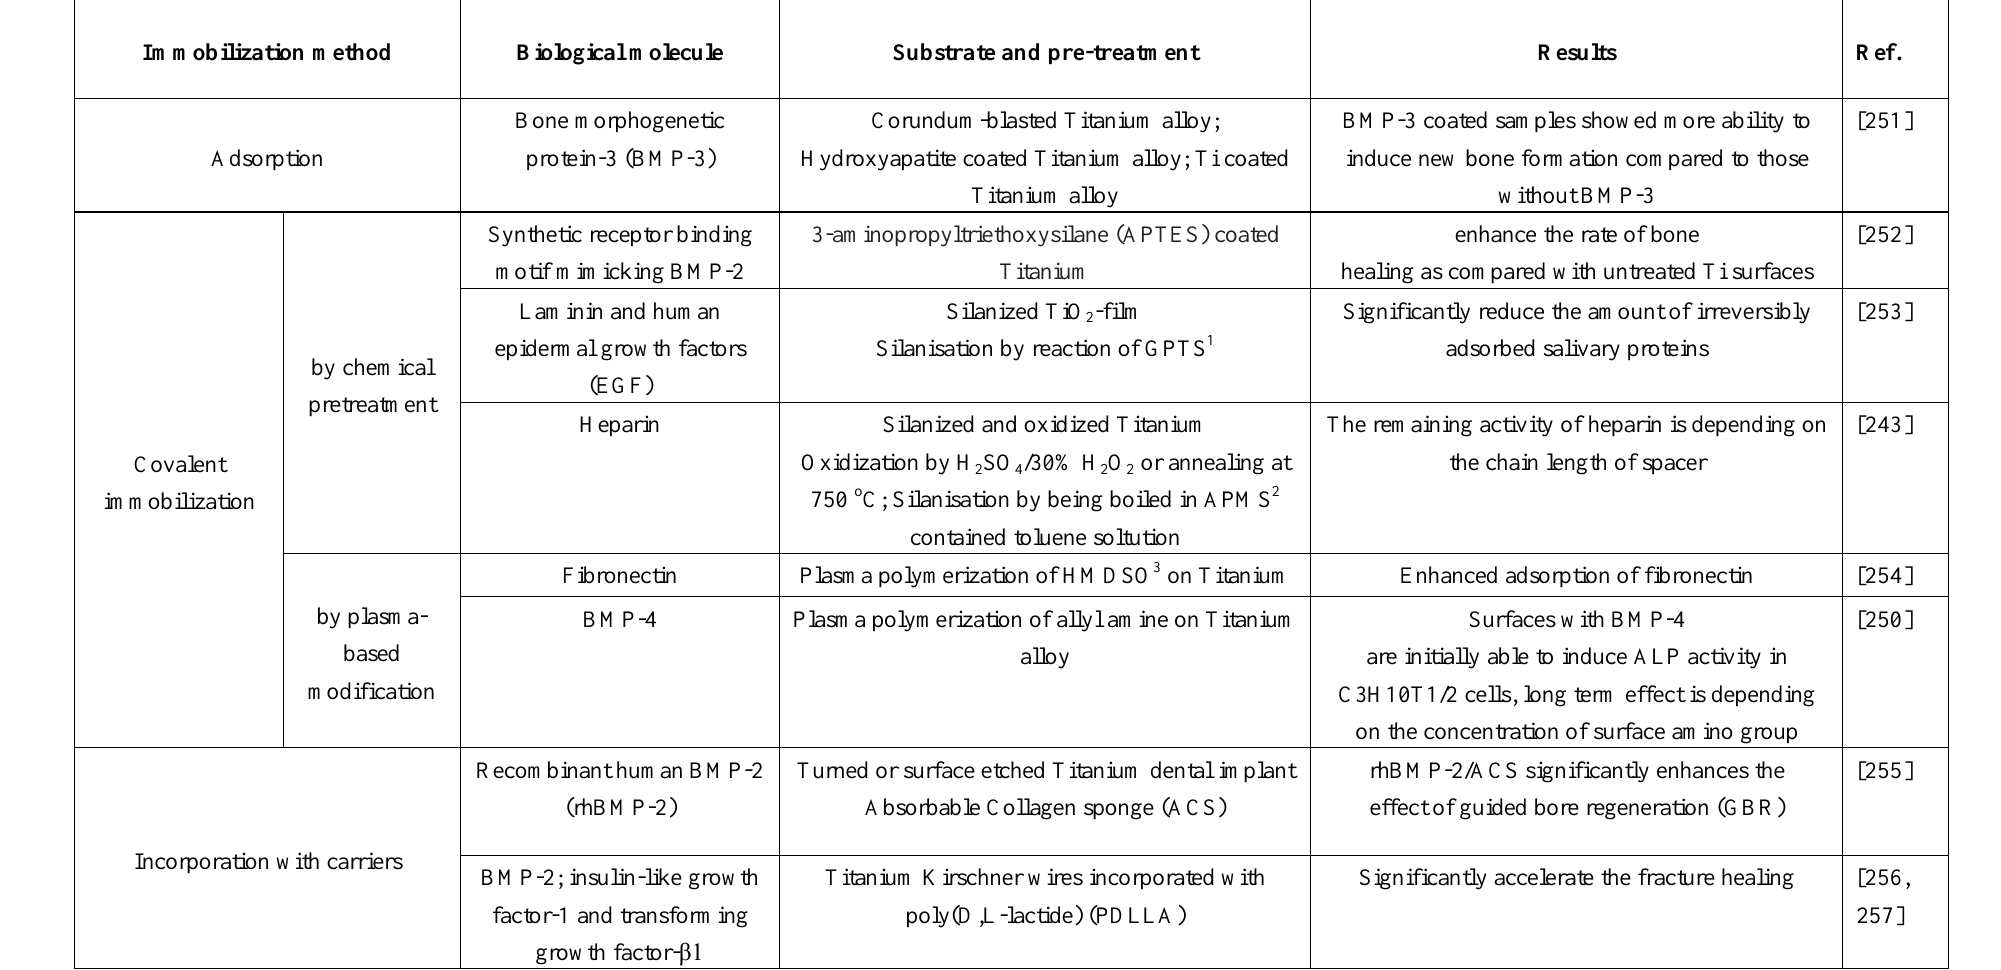
Table 6. Summary of different methods to immobilize bioactive molecules onto the surface of metallic